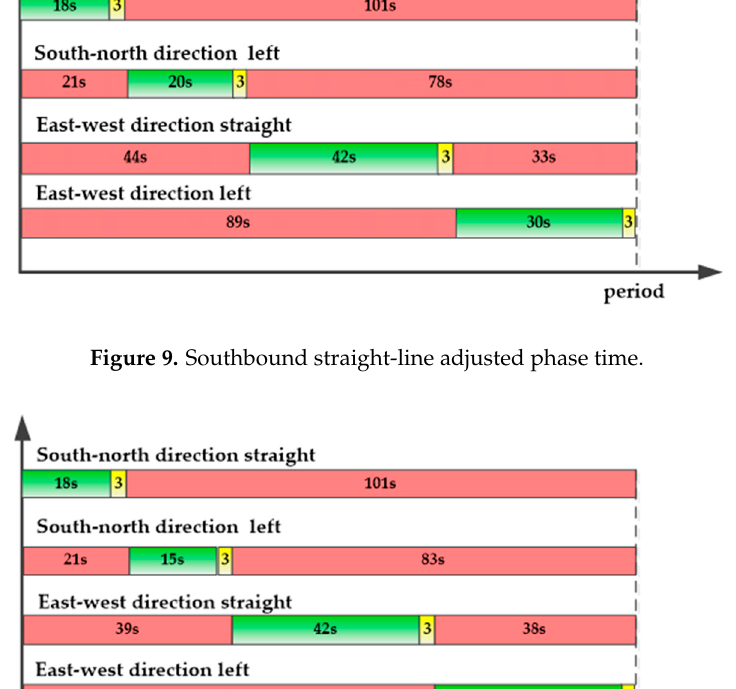
Figure 9. Southbound straight-line adjusted phase time.